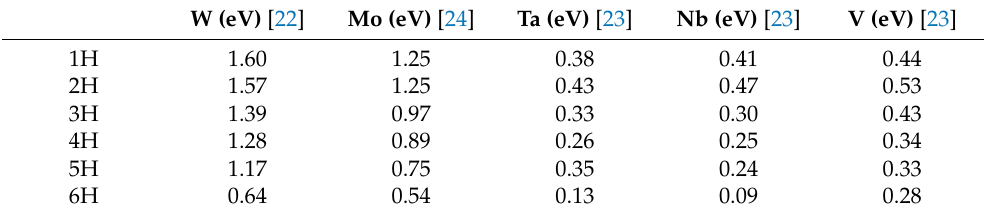
Table 2. Hydrogen trapping energies to monovacancy by element. Energies are calculated by first principles, including ZPE